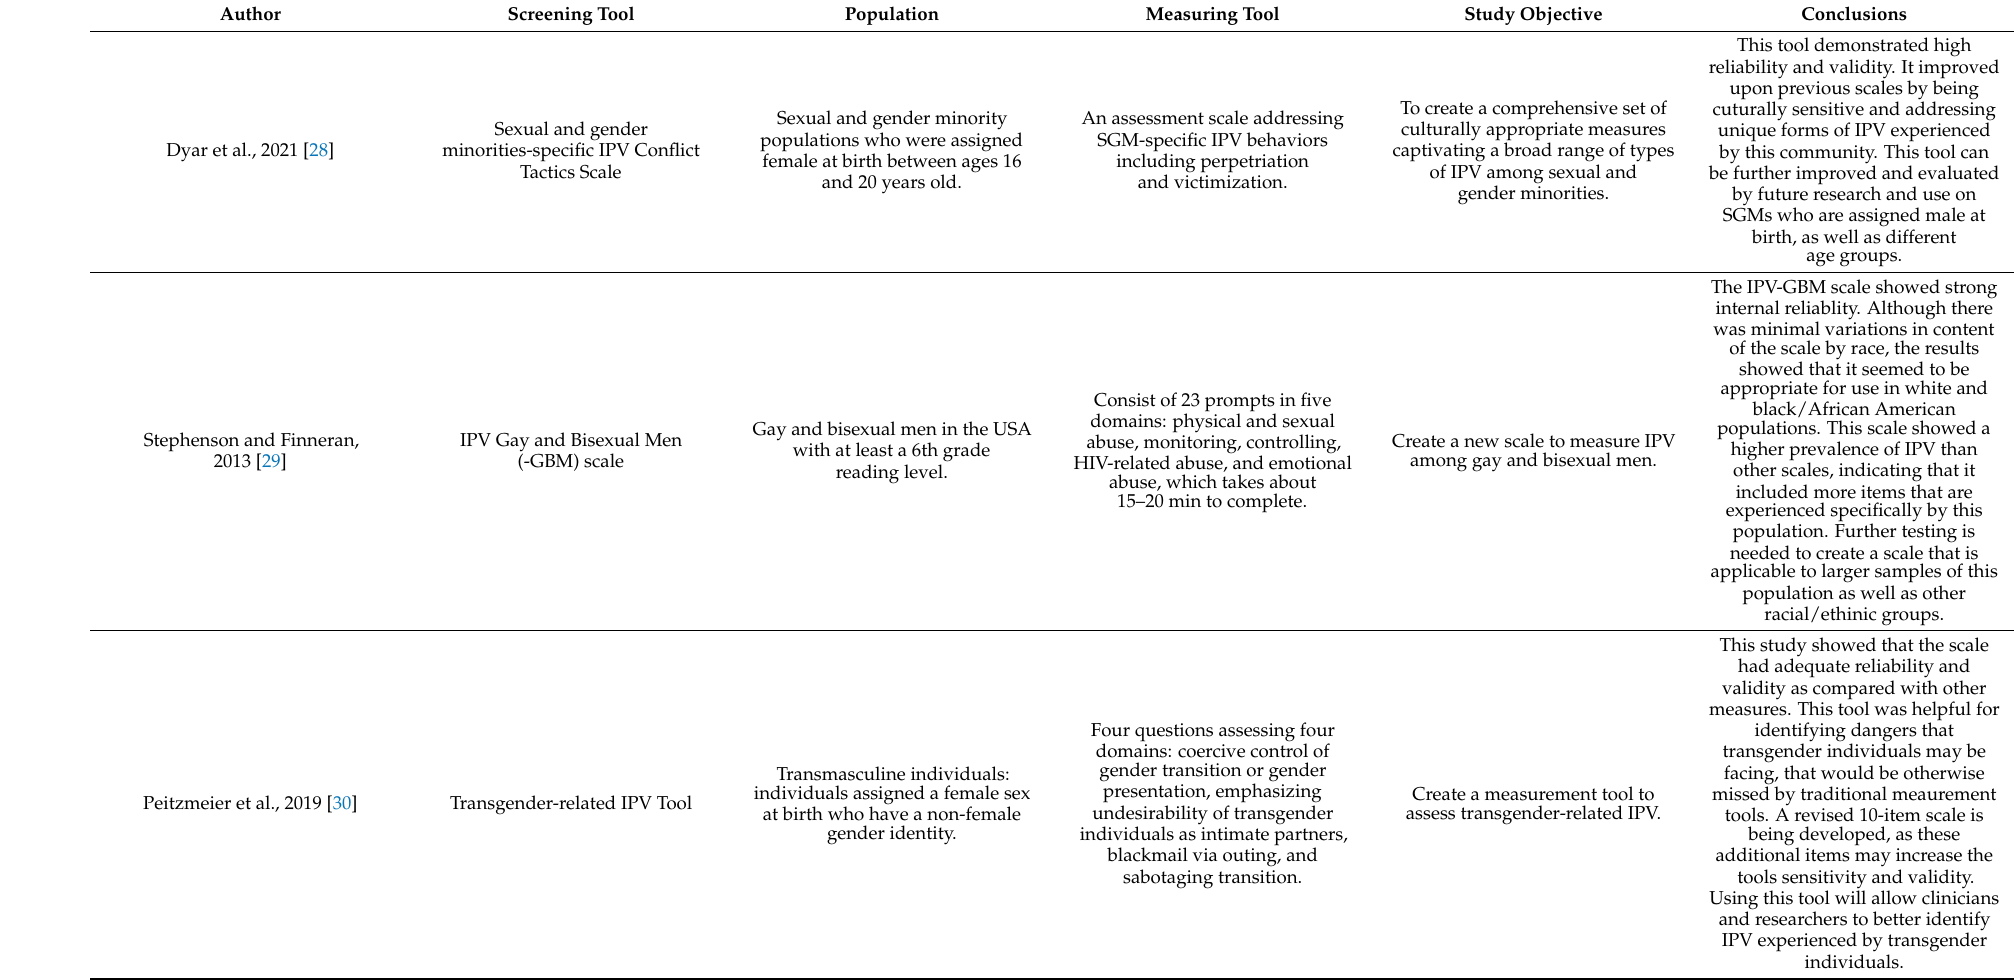
Table 2. Measurement tools for domestic violence in the LGBTQIA+